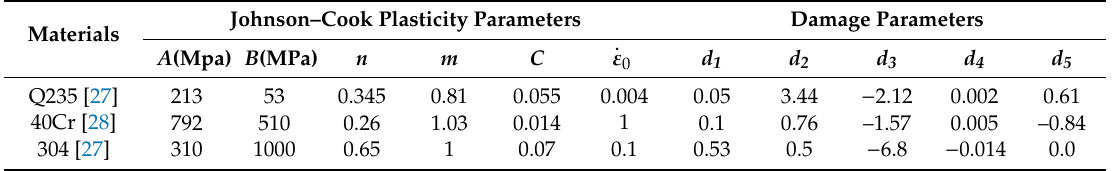
Table 2. The Johnson–Cook plasticity and damage parameters of the bar